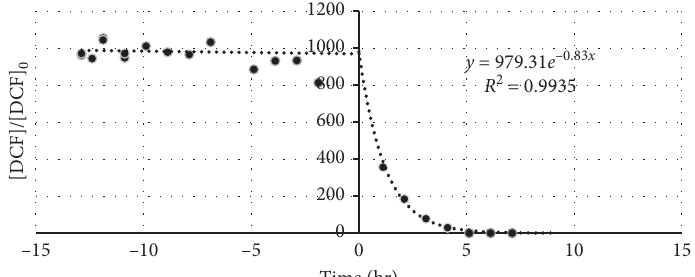
Figure 2: Pseudo-first-order kinetic plot for the degradation of diclofenac initially spiked at 1.0mg · L − 1 over time at 20 ° C. The dotted line (time > 0 h) represents the exponential regression of the measured data using equation (3) and the corresponding coefficient of deter- mination ( R 2